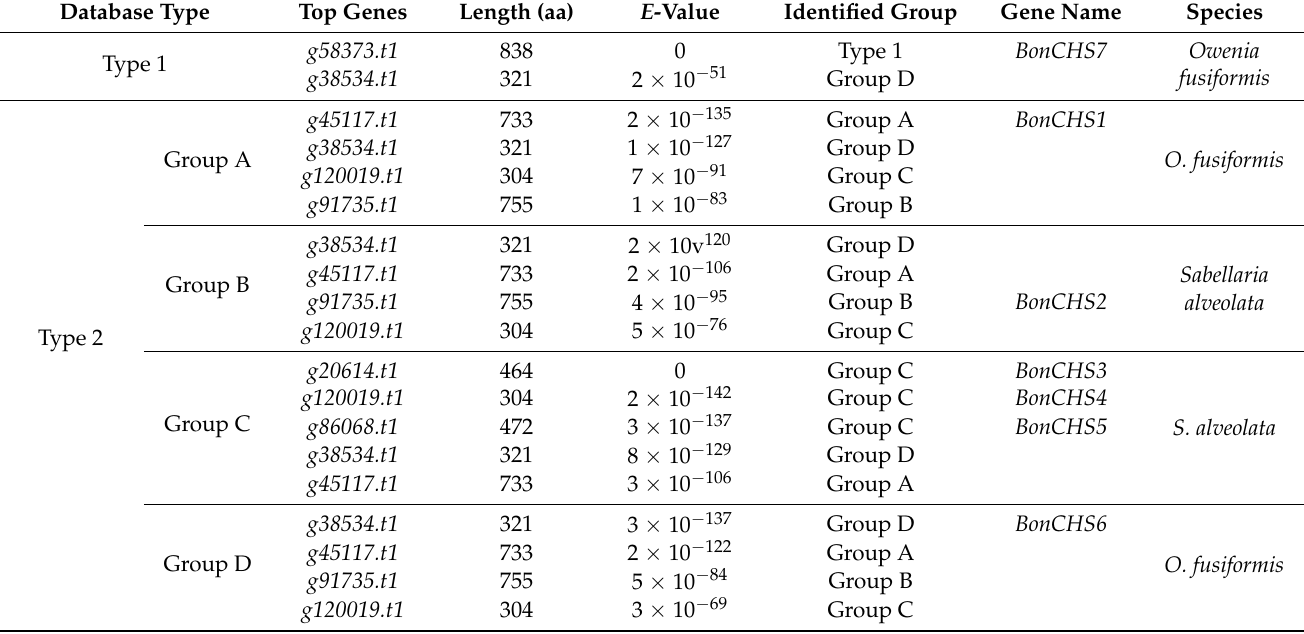
Table 3. BLAST result with E -value cut-off threshold of < 1 × 10 − 50 and length > 300